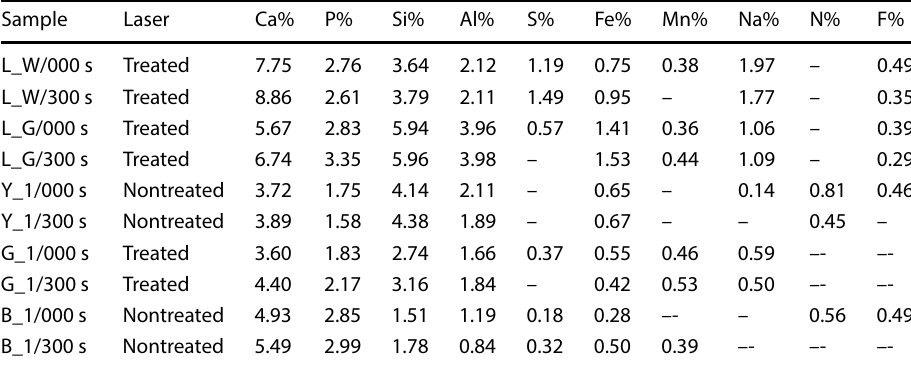
Table 3 Relative surface concentration of elements (atomic %) detected by XPS on the archaeological bone sample before (000 s) and after (300 s) 300 s Ar + ion etching